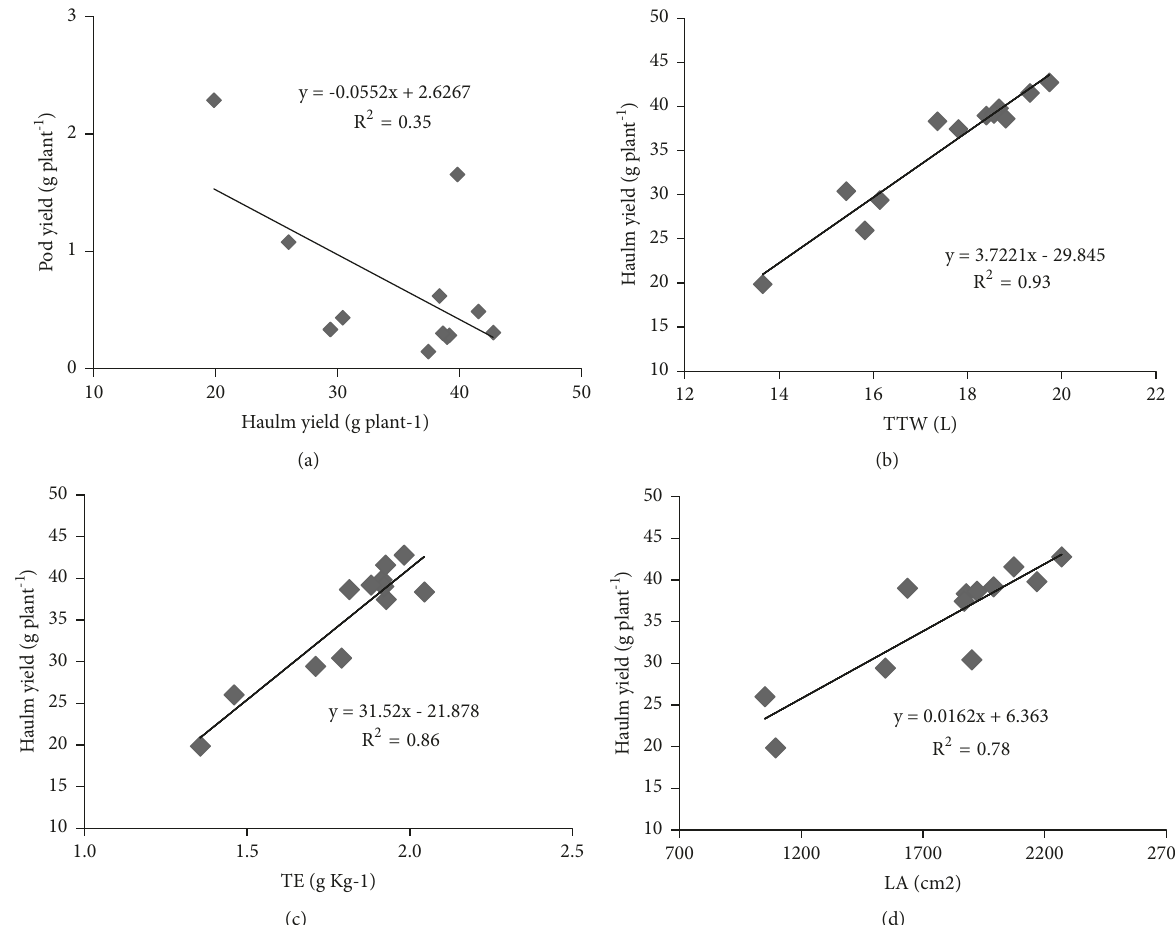
Figure 4: Relationship between pod and haulm weight (a) and between haulm weight and TTW (b), TE (c), and LA (d) under WS condition in lysimeter during year 1 (2017)